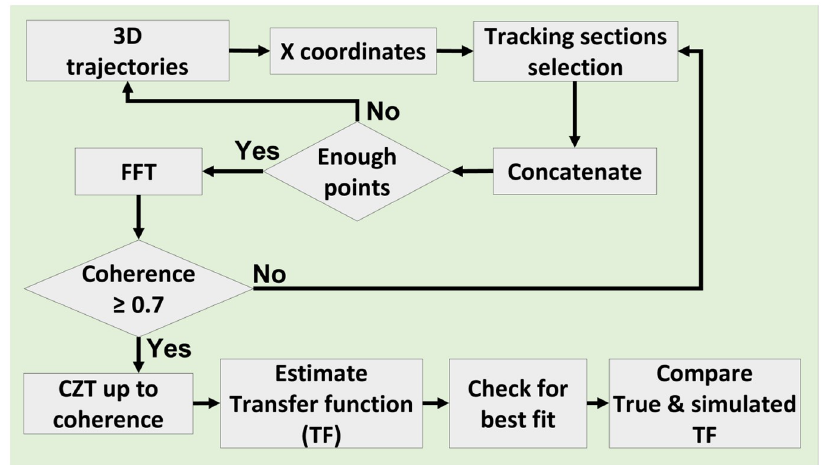
Fig 3. Flowchart of system